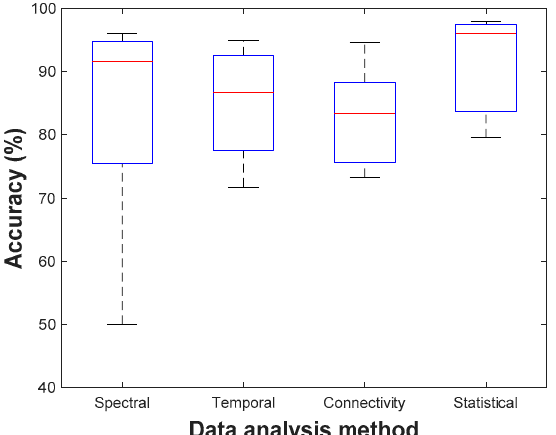
Figure 3. Classification accuracy with MIST stressor.